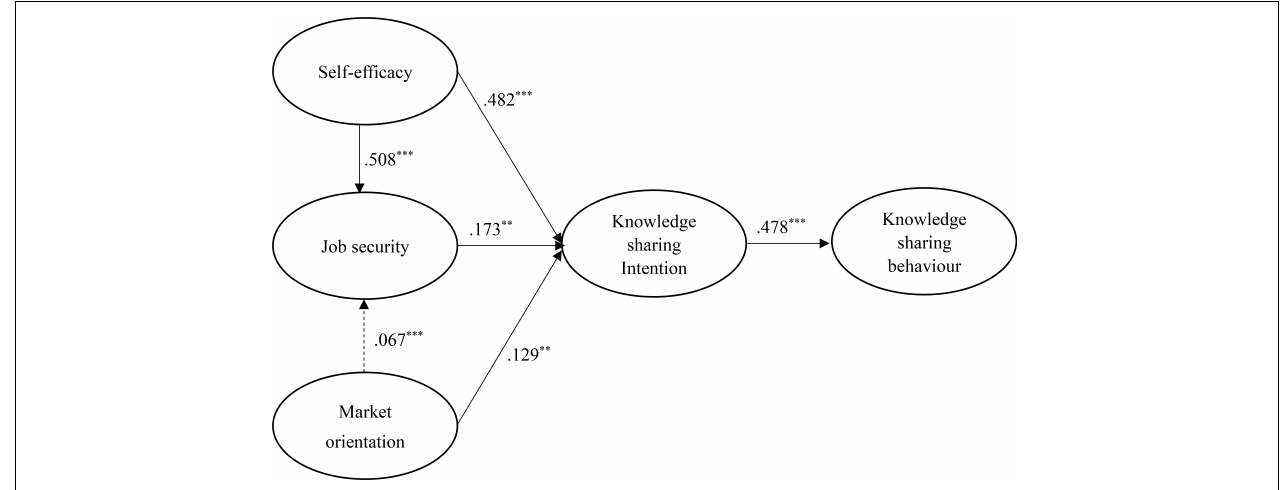
FIGURE 3 | Structural model on Malaysian employees. ** p < 0.01; *** p < 0.001.